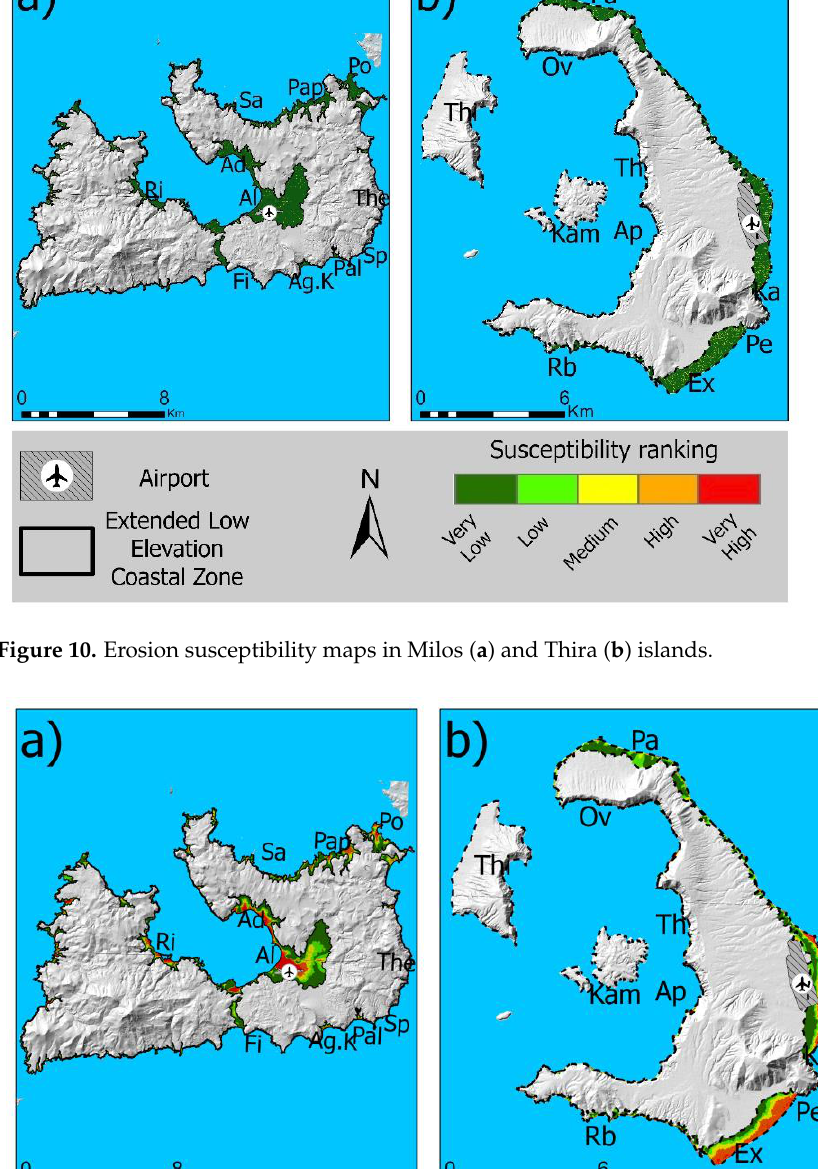
Table 8. Percentages of susceptibility classes to soil erosion in Milos and Thira islands. Very Low